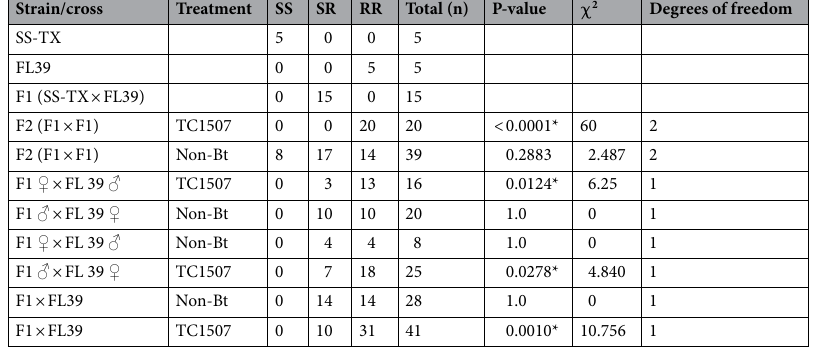
Genomic characterization of the SfABCC2FL1R allele.